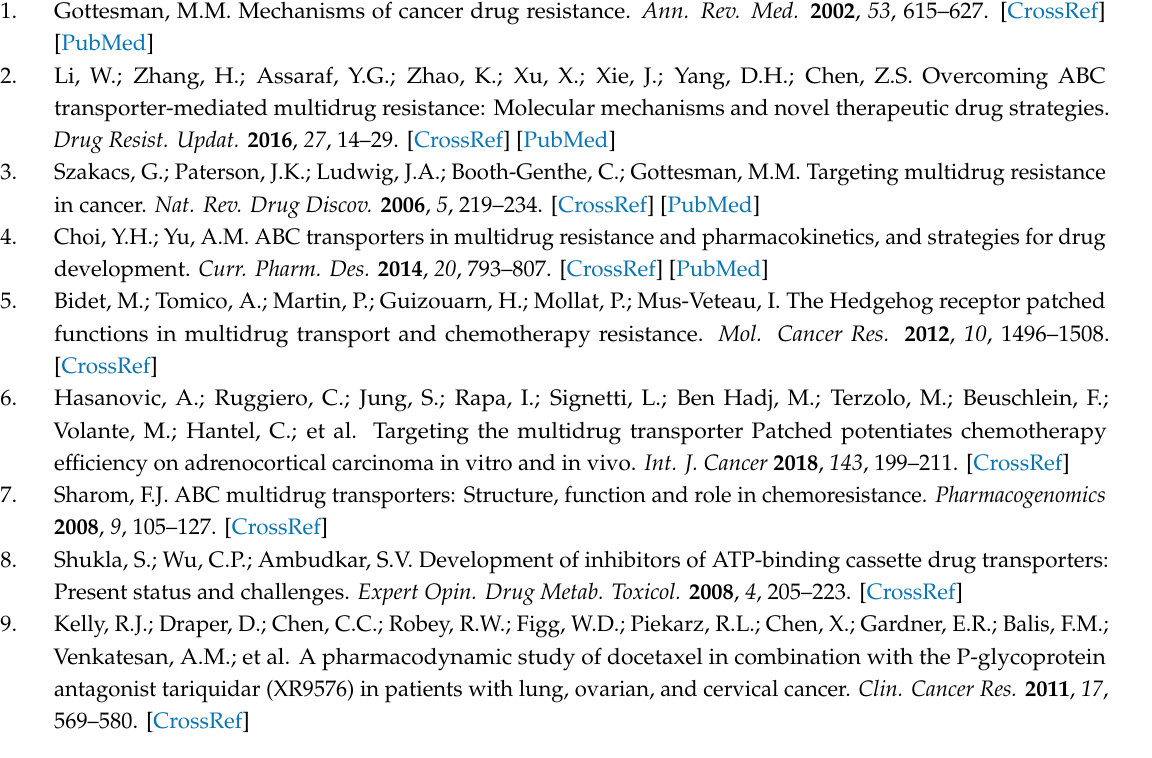
Figure S1: Cytotoxicity of SILA-409 (A) and SILA-421 (B) to MDCK (full symbols) and MDCK-MDR1 cells (open symbols). Means of three experiments ± SD are presented; Figure S2: Fluorescence microscopy images illustrating doxorubicin accumulation in LoVo (A) and LoVo / Dx (B) cells treated with 5 µ M SILA-409 (C and D for LoVo and LoVo / Dx, respectively) and with 5 µ M SILA-421 (E and F). Scale bar is 50 µ m. Illumination conditions were the same for all images; Figure S3: Chemical structures of SILA-409 and